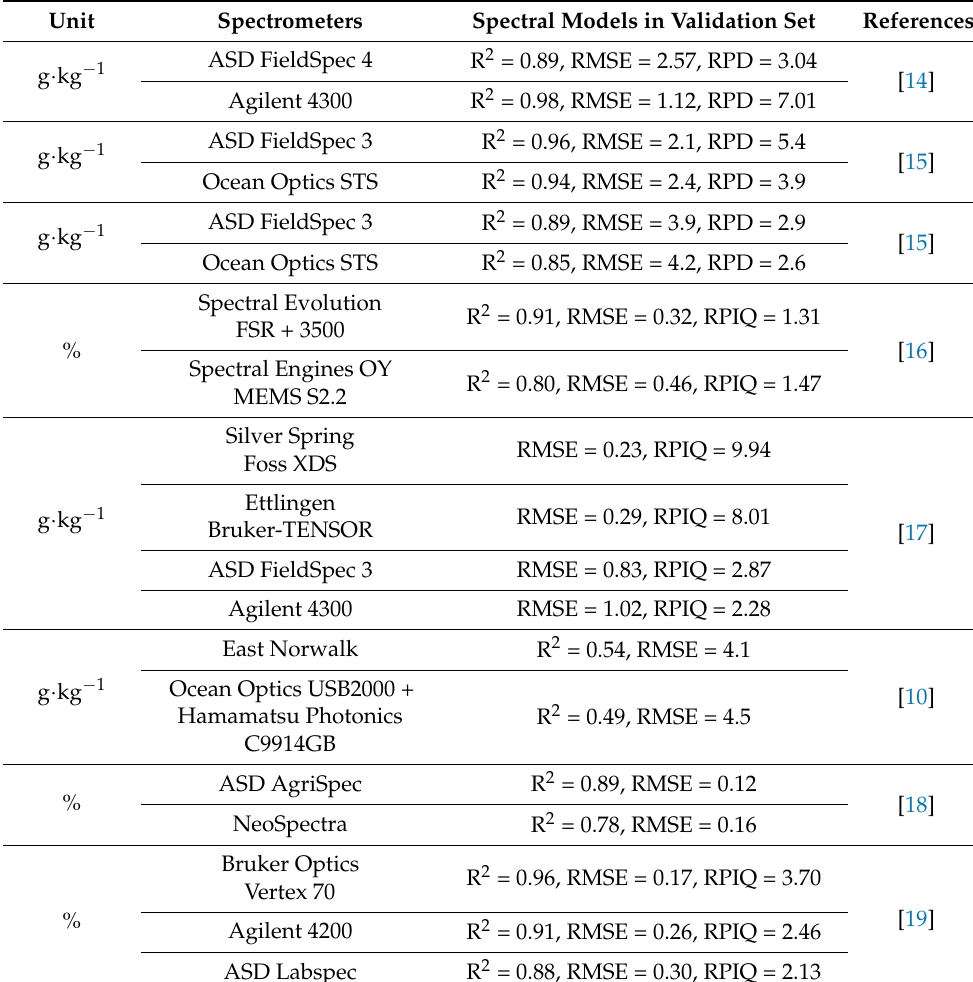
Table 1. Recent studies on spectral analysis of SOC by different spectrometers.